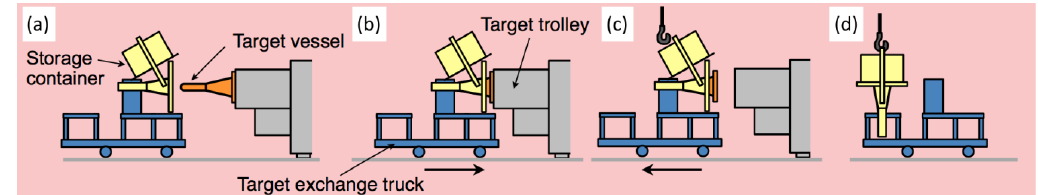
Figure 7. Procedure of the mercury target vessel replacement. ( a ) preparing the target exchange truck and the storage container, ( b ) insert the target vessel into the storage cask, ( c ) removing the target vessel from target trolley, ( d ) move the storage cask to the storage room. New target is set to the target trolley in the reverse order.